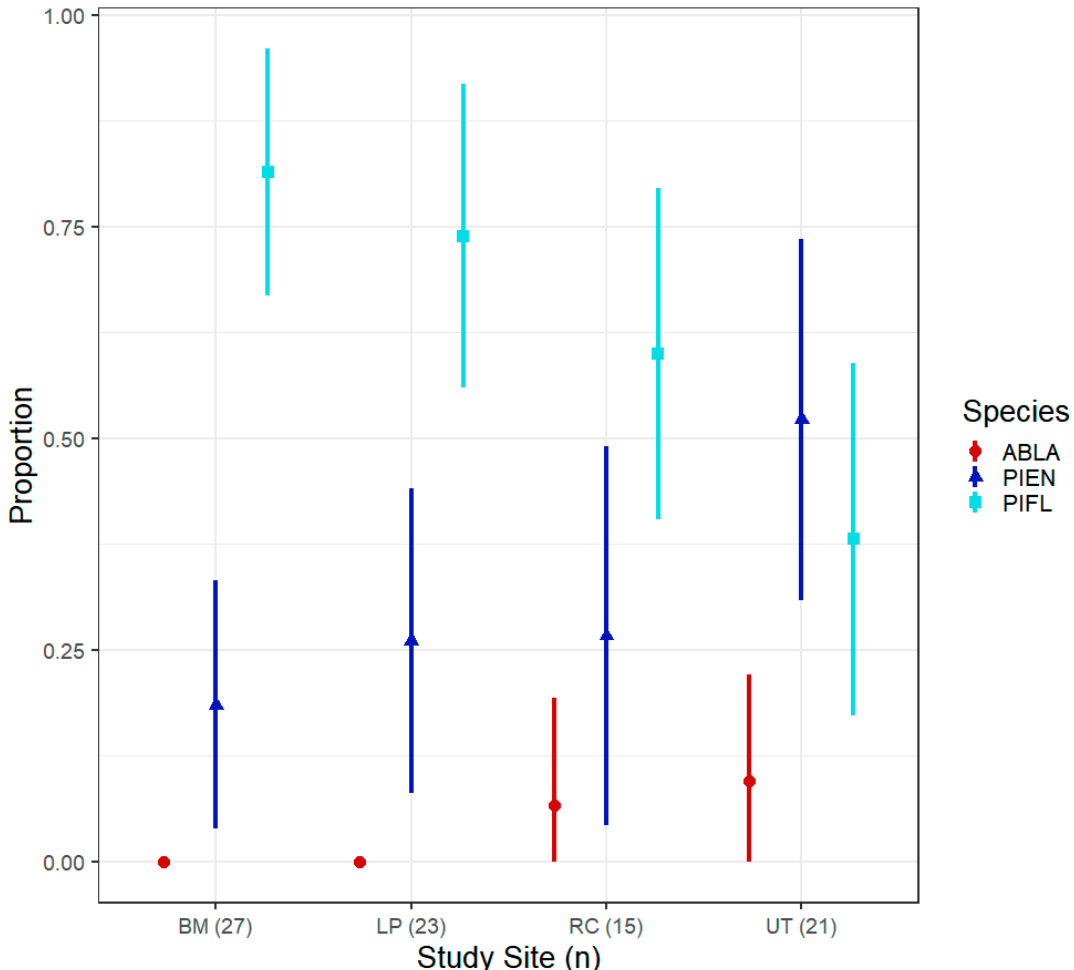
Figure 5. Species proportions and 95% confidence intervals are shown for single-tree islands for subalpine fir ( A. lasiocarpa —ABLA), Engelmann spruce ( P. engelmannii —PIEN), and limber pine ( P. flexilis —PIFL) at the Battle Mountain (BM), Longs Peak (LP), Rainbow Curve (RC), and Ute Trail (UT) study sites. The number of single-tree islands at each site is in parentheses. Where confidence intervals do not overlap, differences are significant at the α = 0.05 threshold.